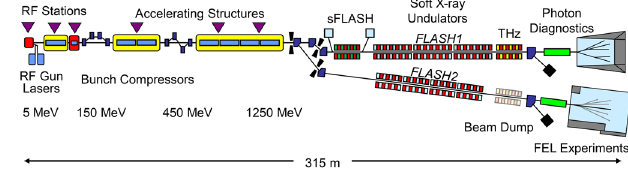
FIG. 13. Schematic layout of the FLASH facility [43].